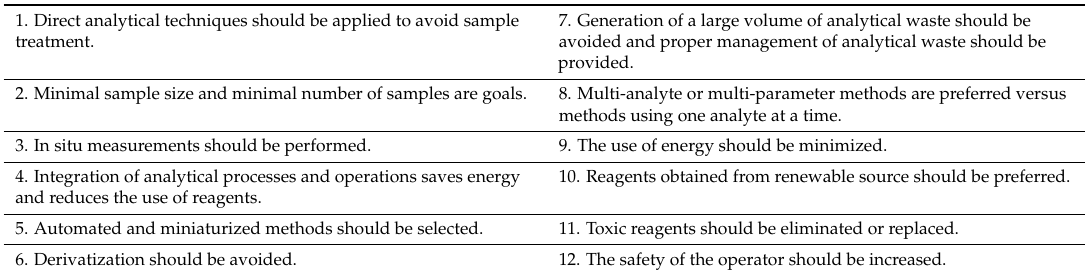
Table 1. Twelve principles of GAC